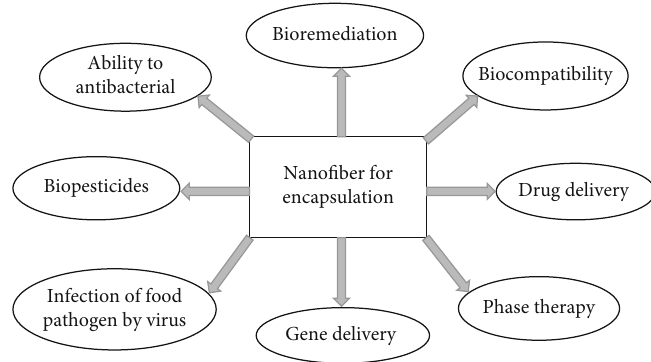
Figure 1: Properties of microorganism encapsulated nano fi bers.